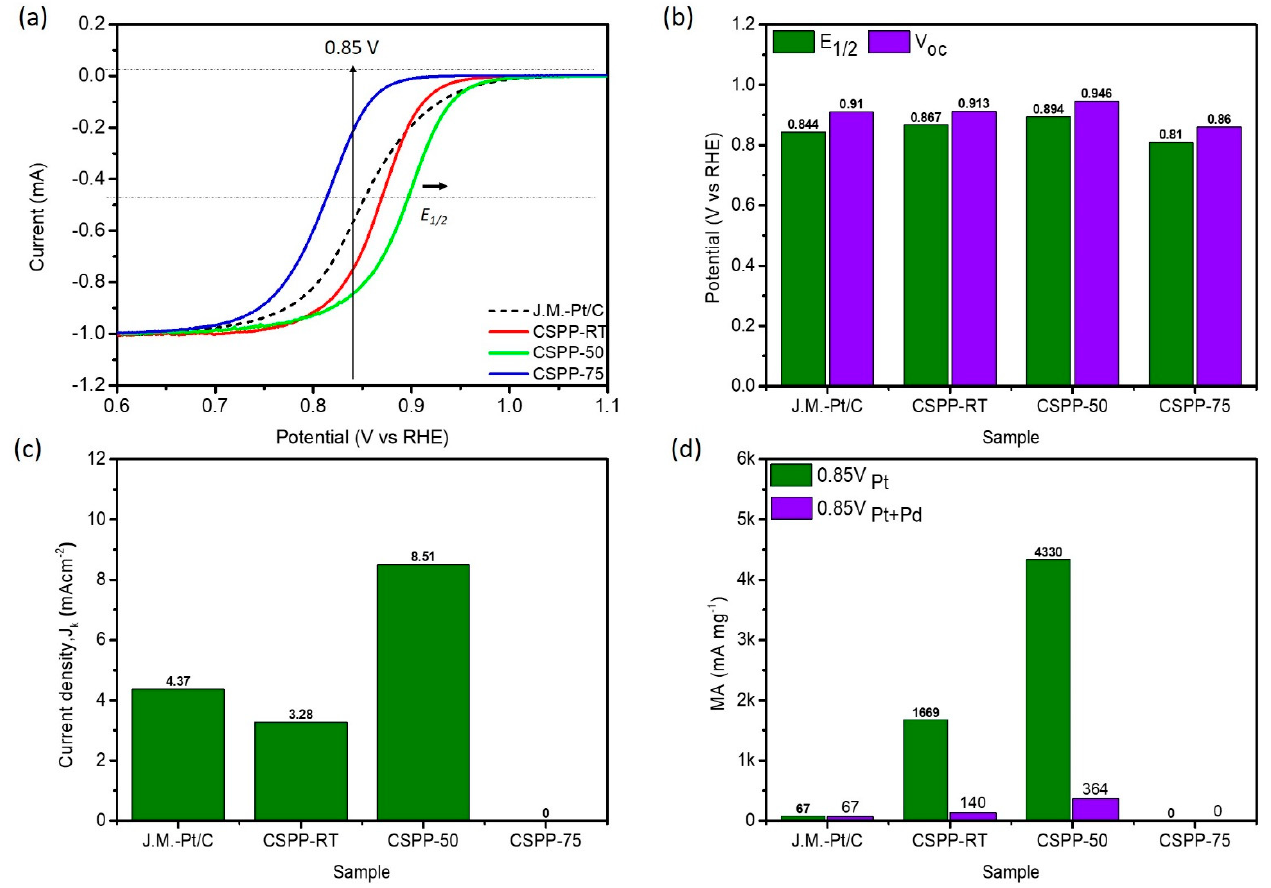
Figure 5. Electrochemical results of CSPP NCs. ( a ) CV and ( b ) LSV curves of CSPP-RT, CSPP-50 and CSPP-75 NCs compared with commercial J.M.-Pt/C NCs. ( c ) kinetic current density at 0.85 V vs. RHE and ( d ) Onset potential (V oc )/half-wave potential (E 1/2 ) compared with commercial J.M.-Pt/C NCs.